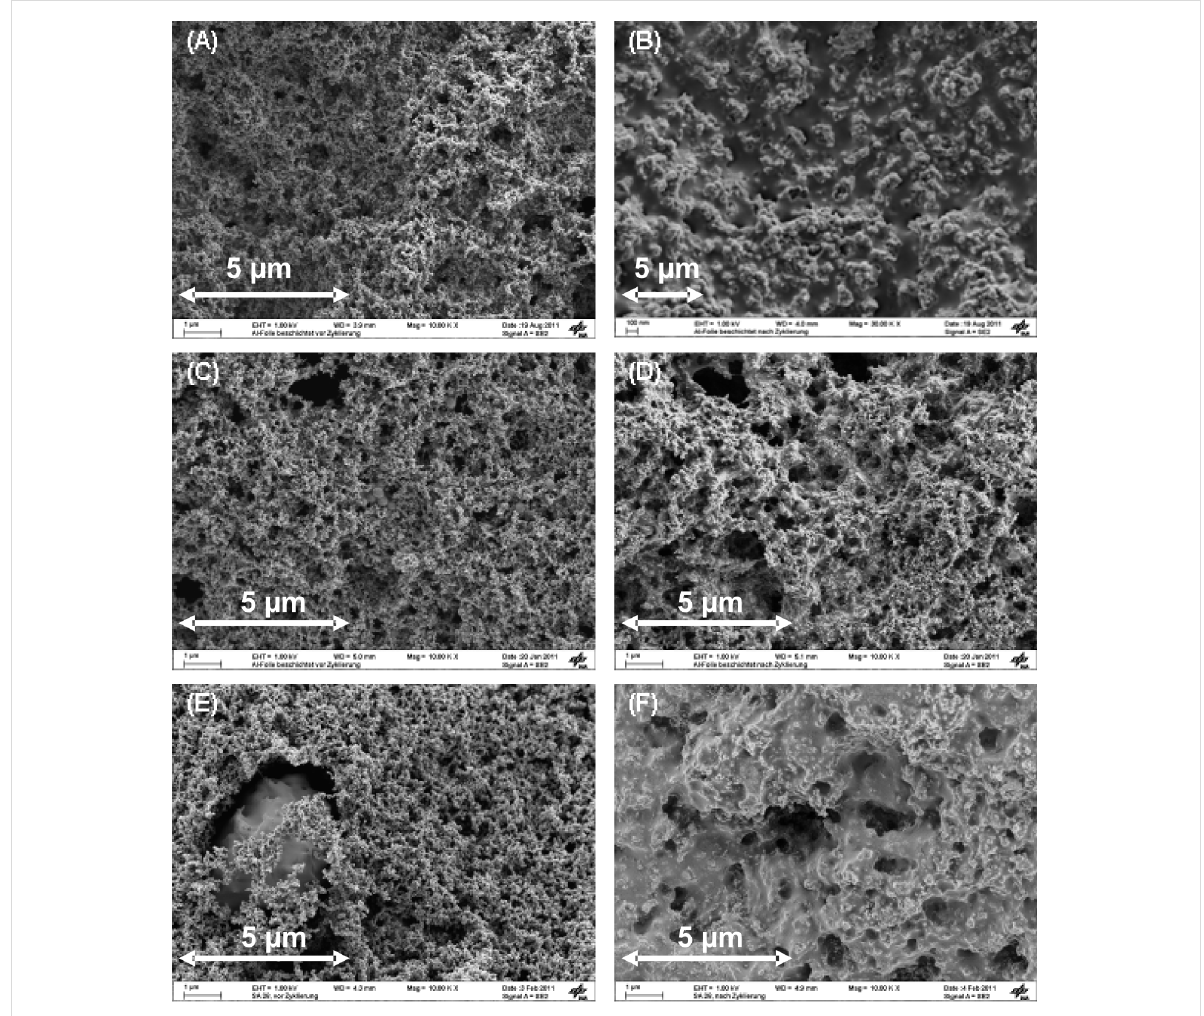
Figure 2: SEM images of (a) DBC-PVDF before cycling, (b) DBC-PVDF after the 50th discharge, (c) SC-PVDF before cycling, (d) SC-PVDF after the 50th discharge, (e) SC-CMC before cycling, (f) SC-CMC after the 50th discharge.